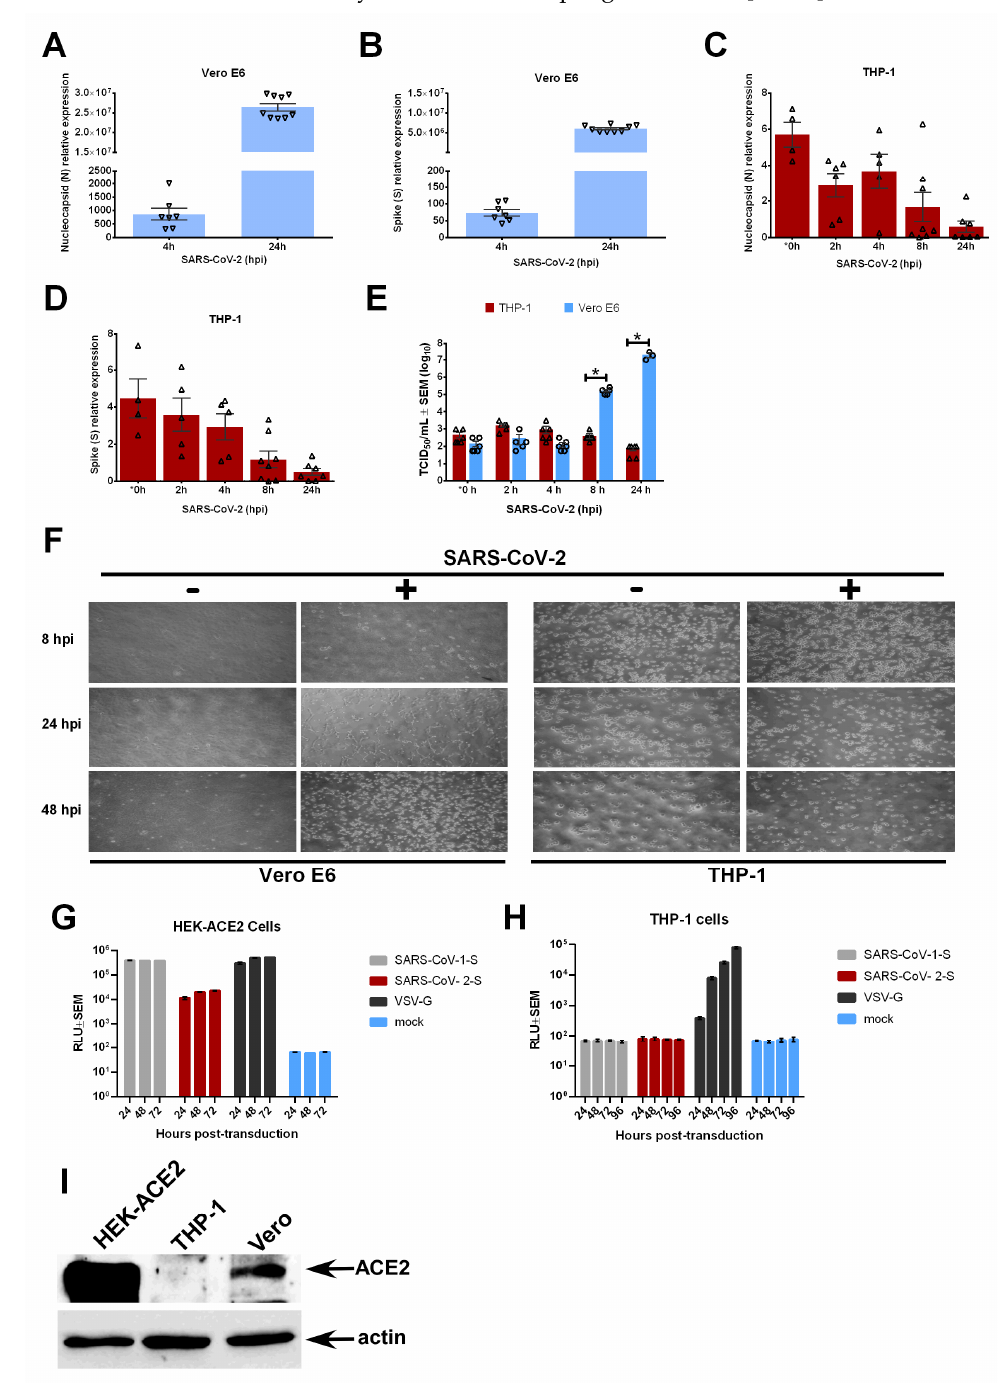
Figure 2. RT-qPCR was used to detect SARS-CoV-2 nucleocapsid or N ( A ) and Spike or S ( B ) viral genes in SARS-CoV-2-infected Vero E6 cells. RT-qPCR was used to detect N ( C ) and S ( D ) viral genes in SARS-CoV-2-infected human THP-1 macrophages. ( E ) Culture supernatants from SARS- CoV-2-infected human THP-1 macrophages and Vero E6 cells were analyzed by TCID 50 assay to determine infectious virus production. ( F ) Bright field microscopy photographs of Vero E6 (MOI = 0.1) and THP-1 (MOI = 0.5) macrophages infected with SARS-CoV-2 for the indicated times. Lumi- nescence (RLU) was measured to determine transduction of HEK-ACE2 cells (HEK293T cells stably expressing human ACE2) ( G ) and THP-1 macrophages ( H ) by luciferase-expressing lentiviruses pseudotyped with VSV glycoprotein (VSV-G), SARS-CoV-1 S protein, or SARS-CoV-2 S protein. ( I ) ACE2 expression was analyzed in HEK-ACE2, THP-1, and Vero cells by Western blotting with ACE2 and actin (loading control) antibodies. Error bars denote the standard error of the mean (SEM) from 2 to 3 biologically independent experiments. hpi = hours post-infection. * p < 0.05 was